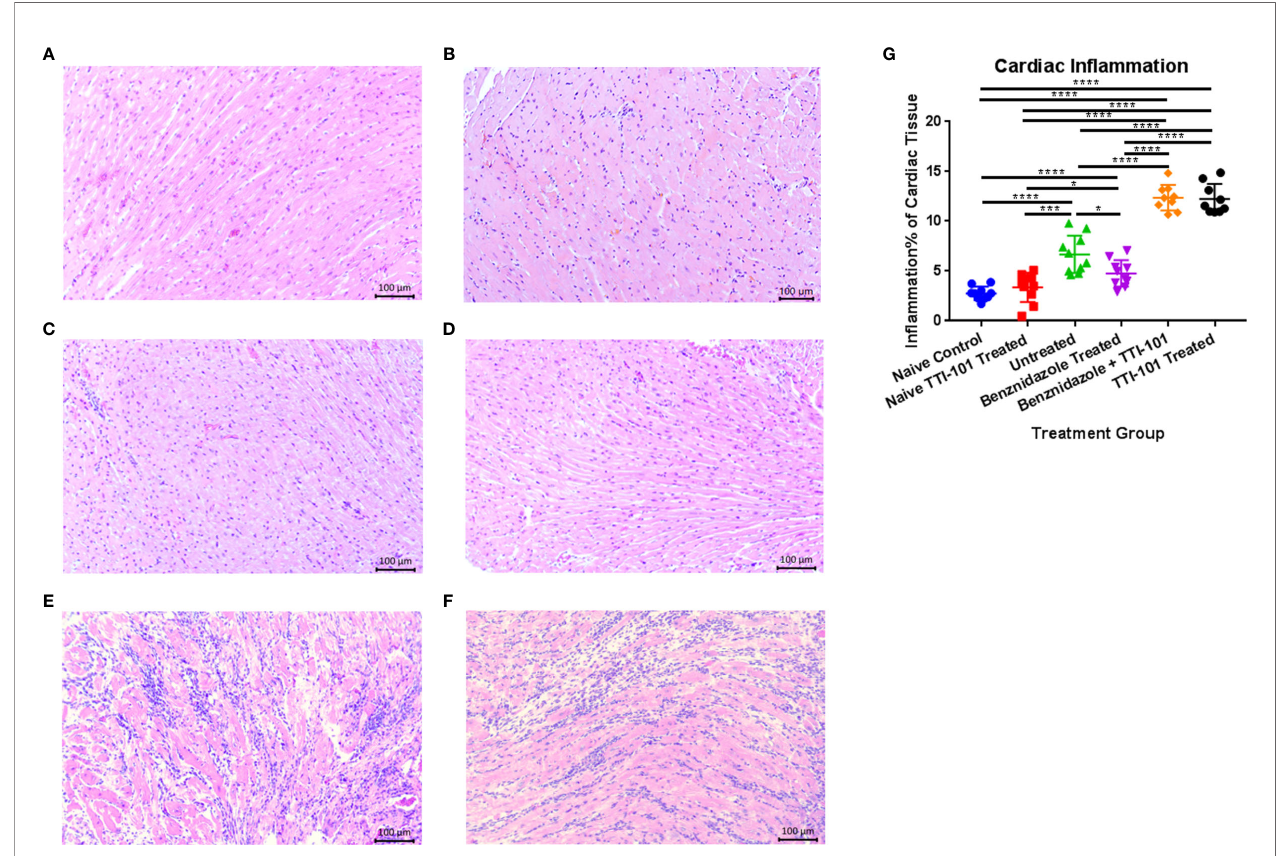
FIGURE 5 | Cardiac in fl ammation quanti fi ed on histopathological analysis in experimental animals. Representative images of hematoxylin and eosin staining of in fi ltrating in fl ammatory cells in naive untreated (A) , naive TTI-101 treated (B) , infected untreated (C) , infected benznidazole treated (D) , infected TTI-101 treated (E) , and infected TTI-101 with benznidazole treated (F) are shown. Relative in fl ammation % of total cardiac tissue imaged is illustrated for 91 days post infection, at the conclusion of treatment (G) . Representative images from one of two replicate experiments are shown. Error bars represent SD. Data were analyzed with Student ’ s t-